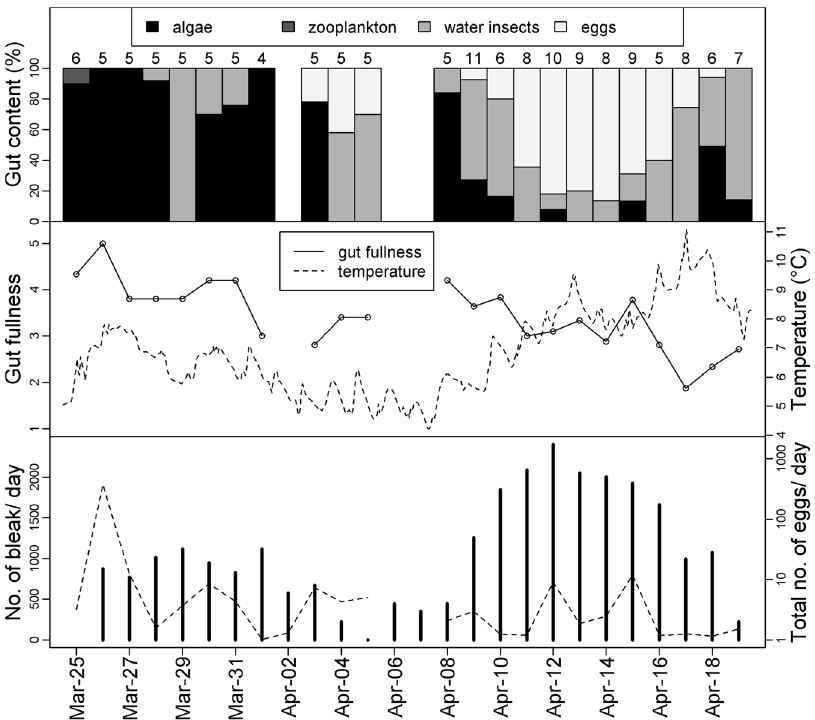
Figure 1. The gut content analysis of bleak (upper and middle panel) and electrofishing estimates of number of bleak within sampling transect (lower panel) in 2015. The numbers above the upper histogram represent the sample size for gut content analysis on a given day. Gut fullness is displayed in the middle panel on a scale of 0–5, with a value of 0 representing empty and a value of 5 fully distended. The temperature is shown by the dashed line. Bottom panel displays the total number of eggs (collected from 12 monitoring tiles, 40 × 40 cm, log 10) and number of bleak in the monitored transect (dashed